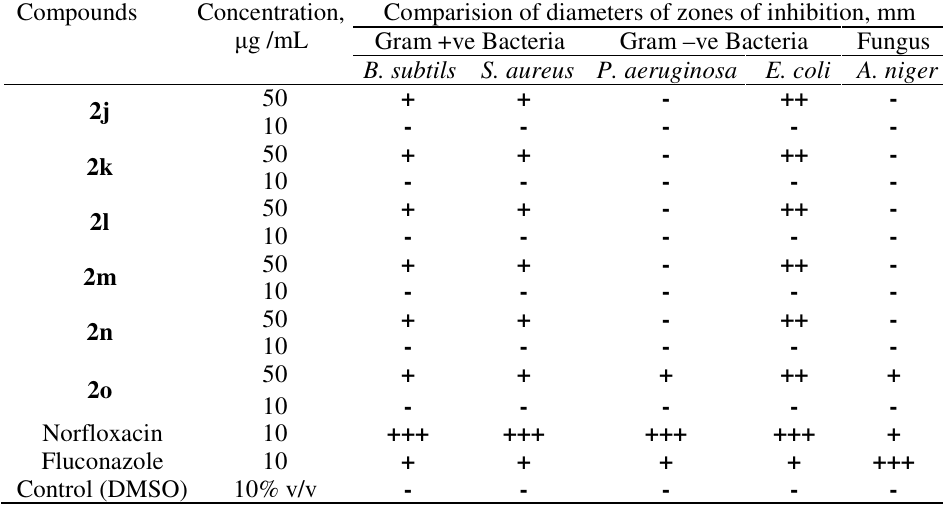
Table 1. Results of Antimicrobial activity of the tested